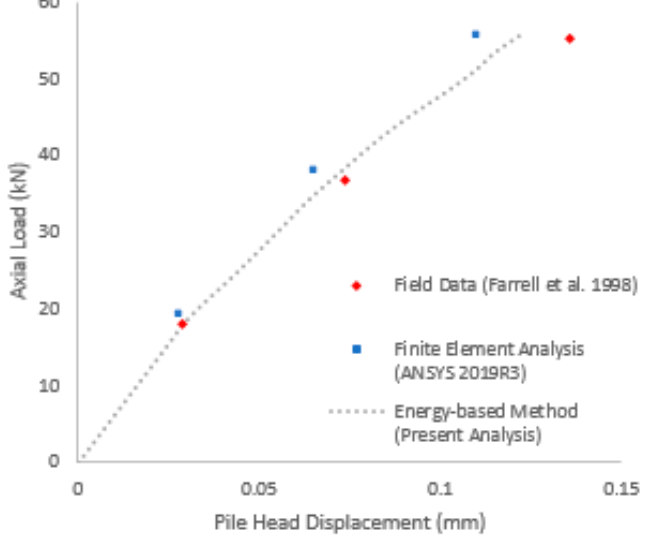
Figure 17. Pile displacements resulting from FEM Analysis.